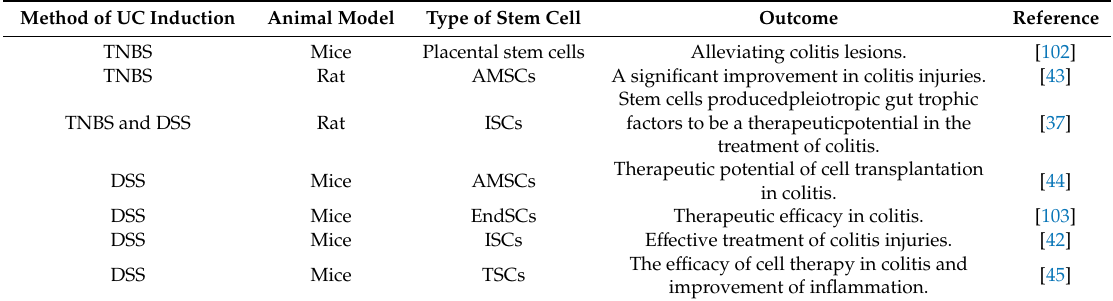
Table 7. In vivo studies in the treatment of UC using other sources of stem